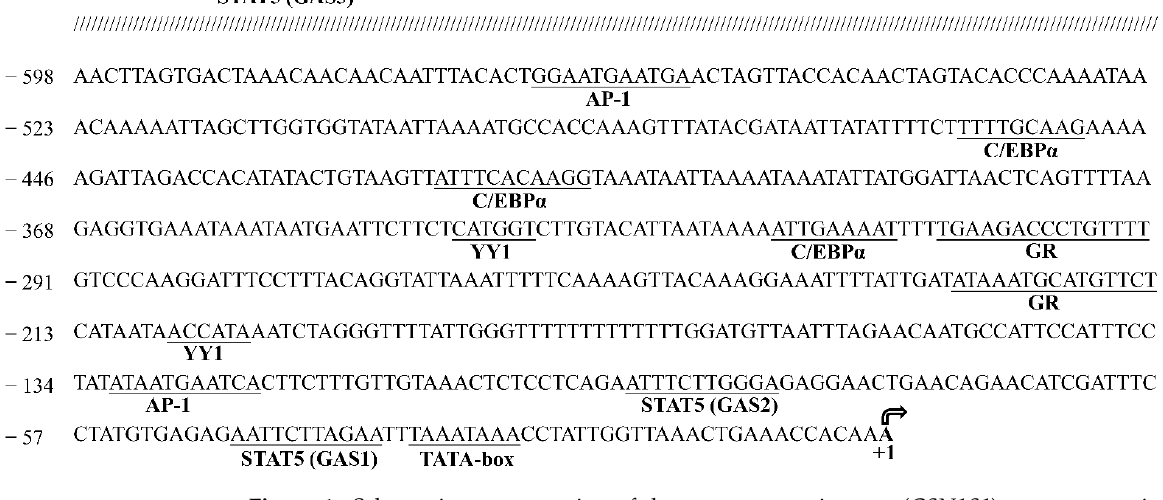
Figure 1. Schematic representation of the goat α S1 -casein gene ( CSN1S1 ) promoter region. The underlined sequence of bases indicates the putative binding sites, and names of transcription factors appear below the underline. +1 represents transcriptional start site and gamma-interferon activation site (GAS) represents the binding site of signal transducer and activator of transcription 5